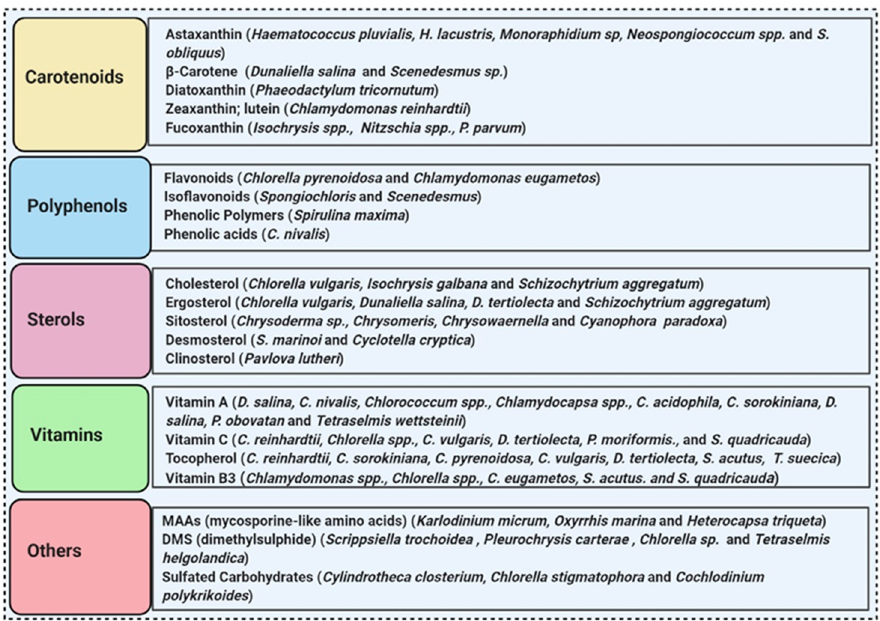
Figure 5. Some antioxidant compounds reported from microalgae.